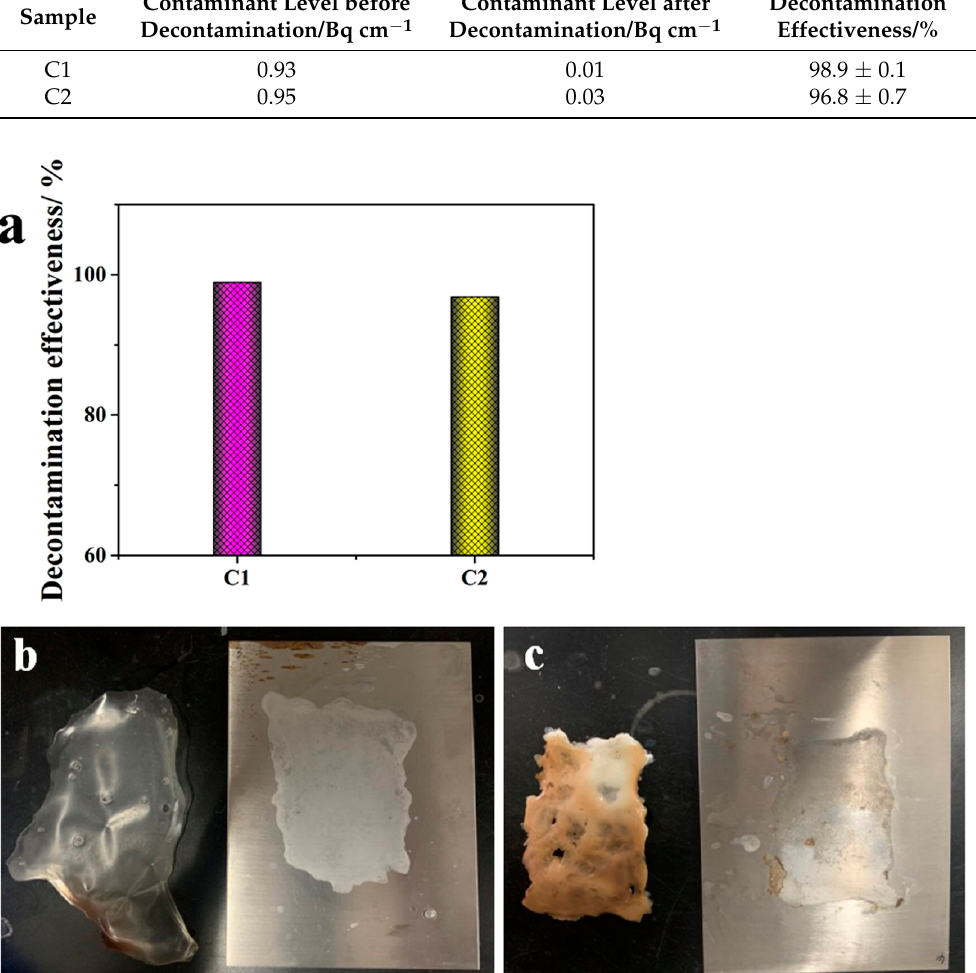
Figure 5. Repeatability of polymeric coating C1 (1 g/L) decontamination. 3.4. Comparison of Surface Decontamination of High Uranium Levels for the Polymer Strippable Coating The high concentrations of surface contaminants vary greatly in practical U contam- ination facilities and can require multiple applications of a decontaminant to reduce the contaminants to acceptable levels. Therefore, a coating with a high decontamination ef- fectiveness for both low and high U radiation levels is urgently needed. To measure their decontamination effectiveness, a decontamination test was performed with the prepared C1 sample and the commercial DeconGel 1101 and surface contamination concentrations of 5 g/L and 22.5 g/L (Figure 6); Table S3 shows the detailed data. At 5 g/L and 22.5 g/L of